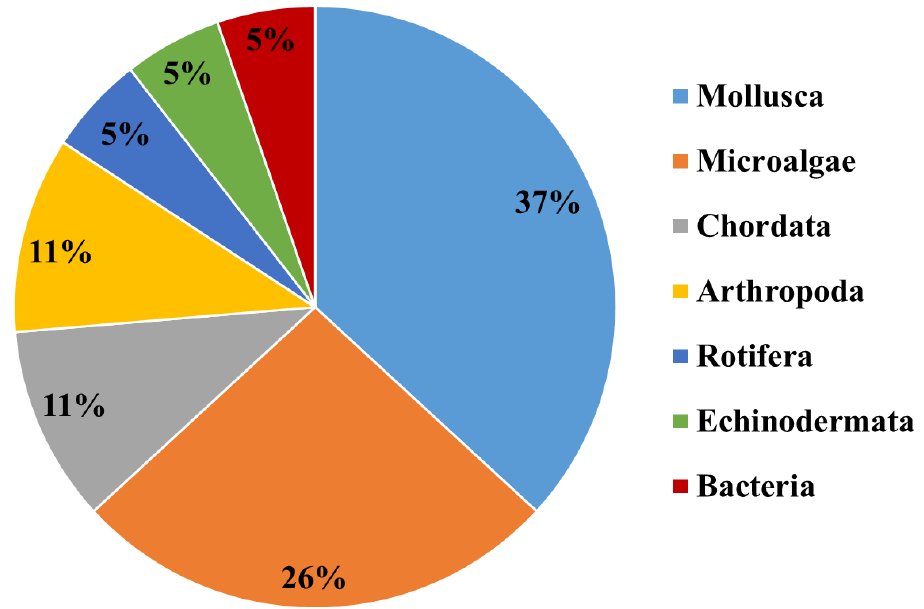
Figure 3. Marine organisms employed for ecotoxicological assessment of ENMs in marine remedi- ation applications belong to the Kingdoms and Phyla indicated in the pie chart (see text for de- tails).